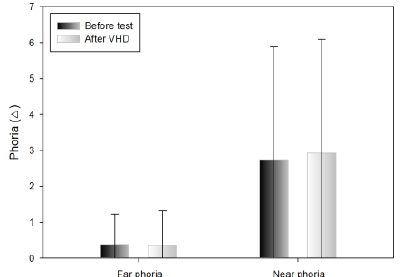
Figure 7. Changes in far and near phoria after the VHD test (*: